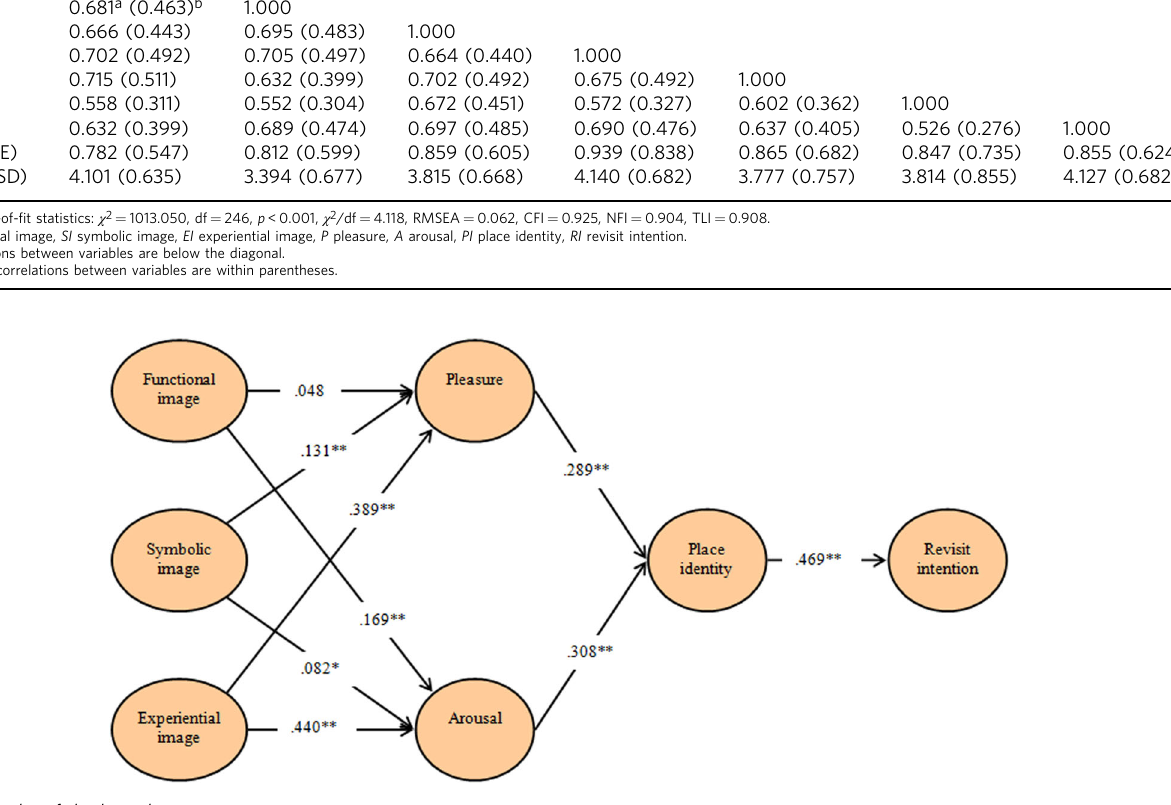
Fig. 2 Results of the hypotheses